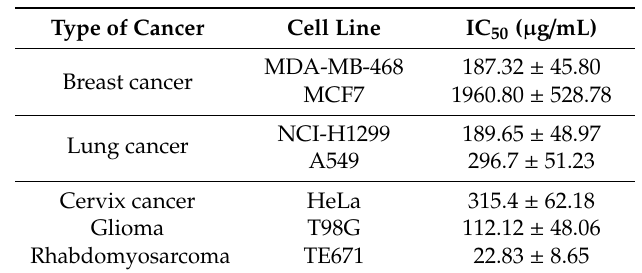
Table 2. Half-maximal inhibitory concentrations (IC 50 ± SD) for the magnoflorine (MGN) for A549, and HeLa cervix cancer cells calculated using computerized linear regression analysis of quantal log dose–probit functions according to the method of Litchfield and Wilcoxon